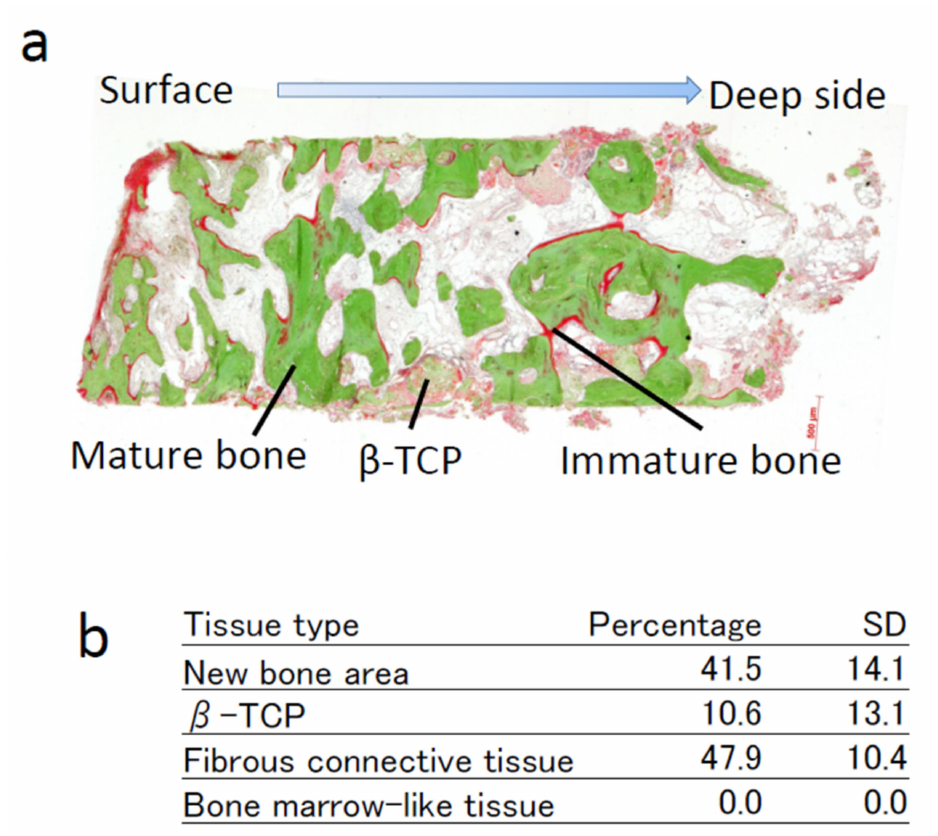
Figure 8. Histomorphometric analysis of bone biopsy samples at 4 months after transplantation. ( a ) Photomicrograph of a representative tissue section. Villanueva–Goldner staining of a non- decalcified section. ( b ) Average percentages and standard deviations (SD) of each tissue in bone biopsy